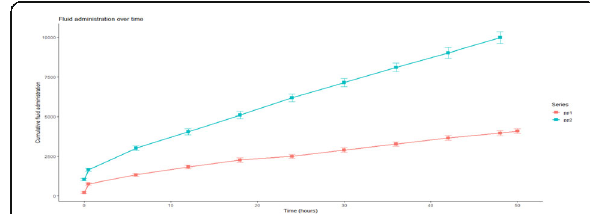
Fig. 1 (abstract 001595). See text for description